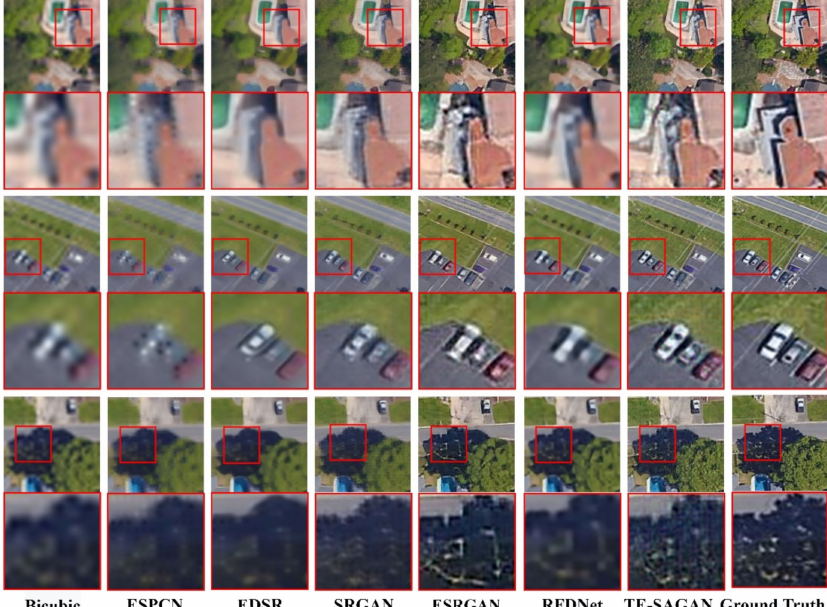
Figure 9. Image processing results of the different algorithms using the test dataset, including the details of roof, cars, and tree shadows.